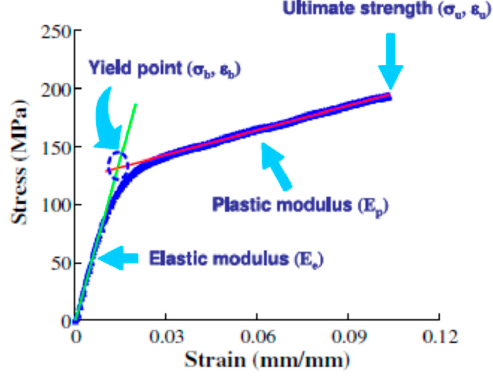
Figure 3. Typical pull test results of cellulose EAPap [32].